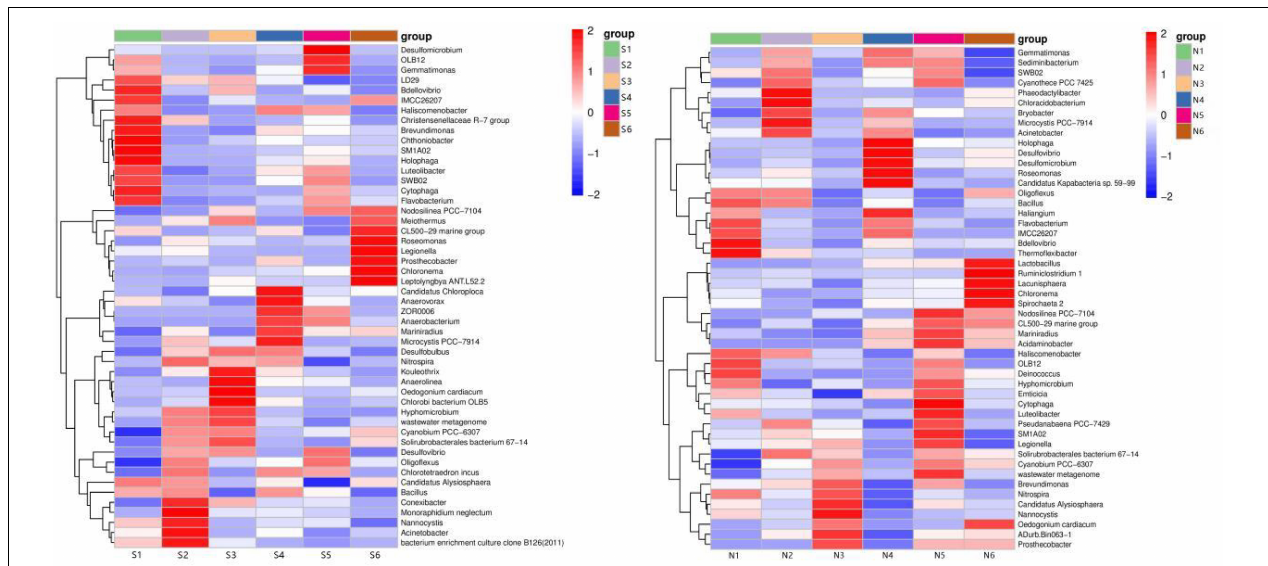
FIGURE 6 | Genus-level heat map-cluster analysis of microbial communities in sediments from South (S) and North Taihu Lake